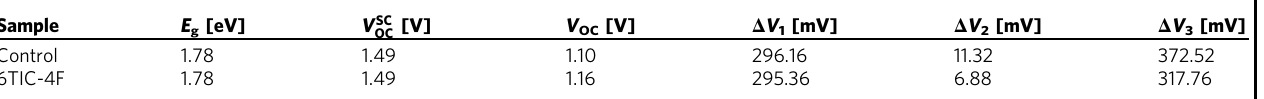
Table 2 The V OC loss analysis of the studied devices without and with 6TIC-4F